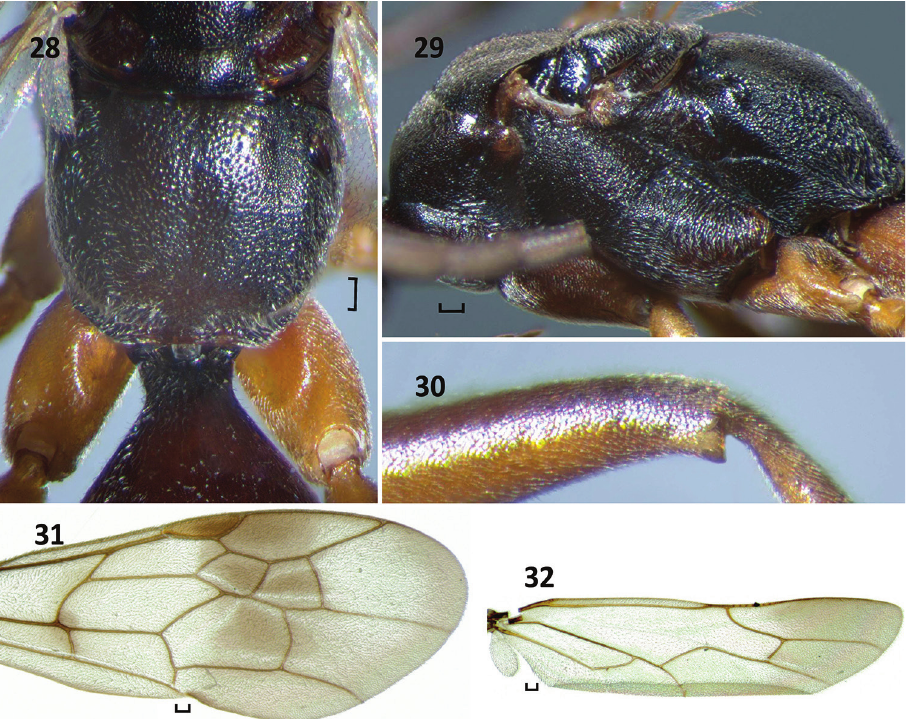
Figures 28–32. Nipponodipogon shimizui Loktionov, Lelej & Xu, sp. n., female, paratype. 28 Meso- scutellum, metanotum, metapostnotum, propodeum and T1, dorsal view 29 Mesosoma, lateral view 30 Metafemur, outer lateral view 31 Fore wing 32 Hind wing. Scale bars 0.1 mm.